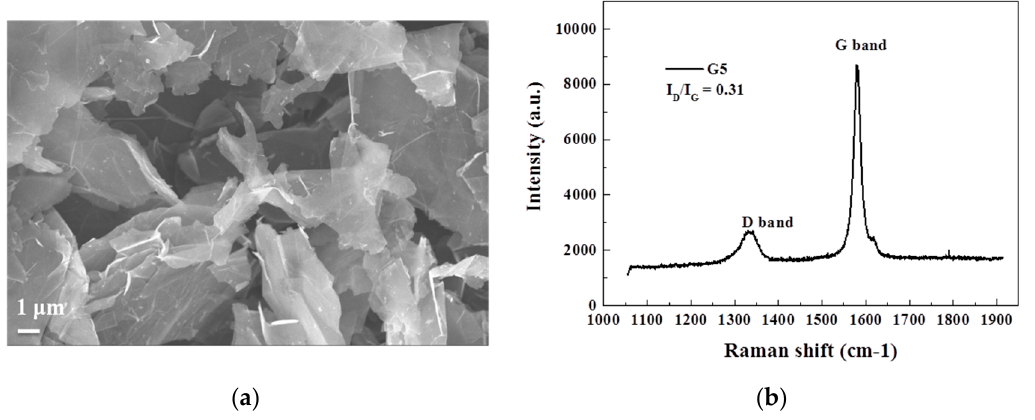
Figure 2. ( a ) SEM image and ( b ) Raman spectrum for G5 powder.